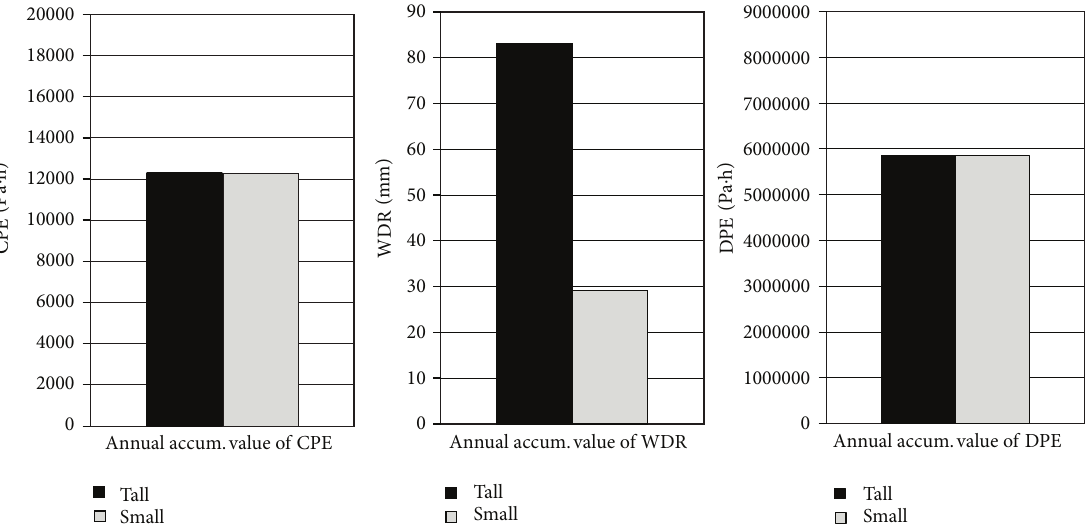
Figure 13: Characteristics of the fac¸ade: orientation.